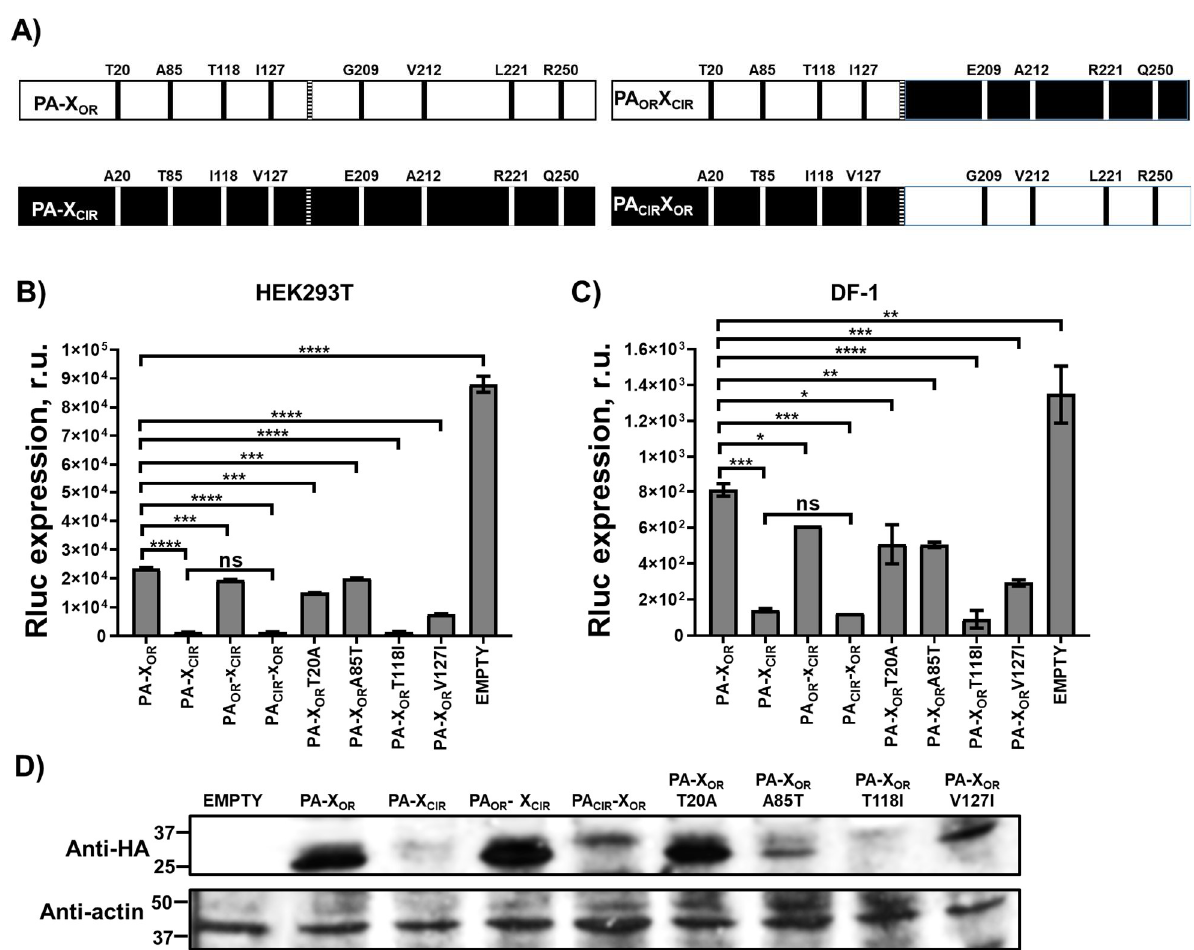
Figure 3. Effect of H5N1 IAV PA-X amino acid changes on host gene expression. ( A ) Schematic representation of H5N1 IAV PA-X WT and chimeric constructs. ( B , C ) Human HEK293T ( B ) and avian DF-1 ( C ) cells were transiently co-transfected with an empty pCAGGS plasmid control, or with pCAGGS plasmids expressing the indicated HA epitope-tagged H5N1 PA-X constructs, together with Rluc-expressing plasmid. PA-X CIR protein encodes the amino acid changes T20A, A85T, T118I, I127V, G209E, V212A, L221R, and R250Q. PA OR -X CIR encodes the amino acid changes G209E, V212A, L221R, and R250Q. PA CIR -X OR encodes the amino acid changes T20A, A85T, T118I, and I127V. In addition, plasmids encoding PA-X OR proteins containing single amino acid changes T20A, A85T, T118I, and I127V were transfected. At 24 h.p.t, Rluc expression ( B , C ) was quantified in a luminometer. Error bars represent the standard deviations from triplicates. *, p < 0.05; **, p < 0.005; ***, p < 0.0005; ****, p < 0.0001 using a Student’s t -test. R.u., relative units. ( D ) Protein expression levels of H5N1 PA-X and actin in HEK293T transfected cells were analyzed by Western blot using cells extracts and antibodies specific for the HA tag to detect PA-X proteins (upper blot) and actin (bottom blot). Molecular mass markers (in kDa) are indicated on the left. The experiments were repeated three times, with similar results.